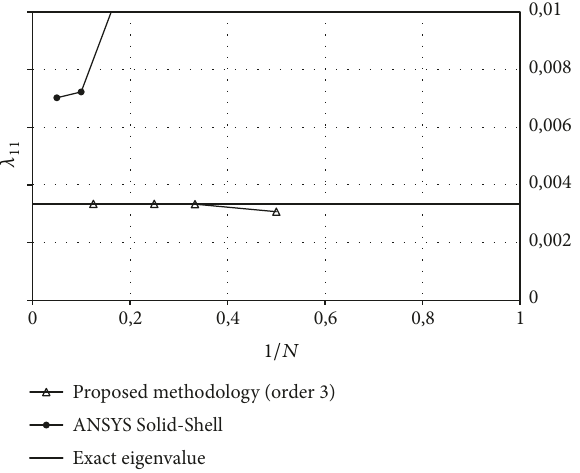
Figure 27: Hinged rectangular plate: gence).